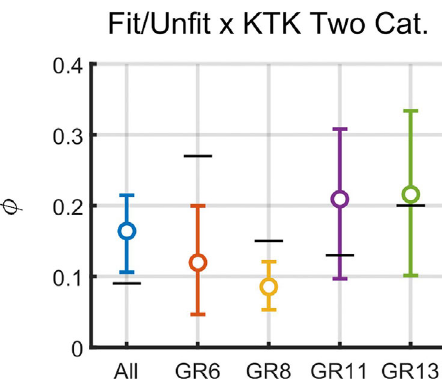
Figure 3 - Association ( ϕ ) between the broad Fit/Unfit category from the Fitnessgram and the broad category of Sufficient/Insufficient Coordina- tion from KTK for all ages (not controlling for age and sex) and for each age group (partial correlation controlled by sex). The circle represents the mean and the error bars of the 95% confidence interval of the bootstrap distribution after 10000 iterations. The black line represents the mini- mum value required for significance (the mean and confidence intervals need to be above that line to be significant at p <